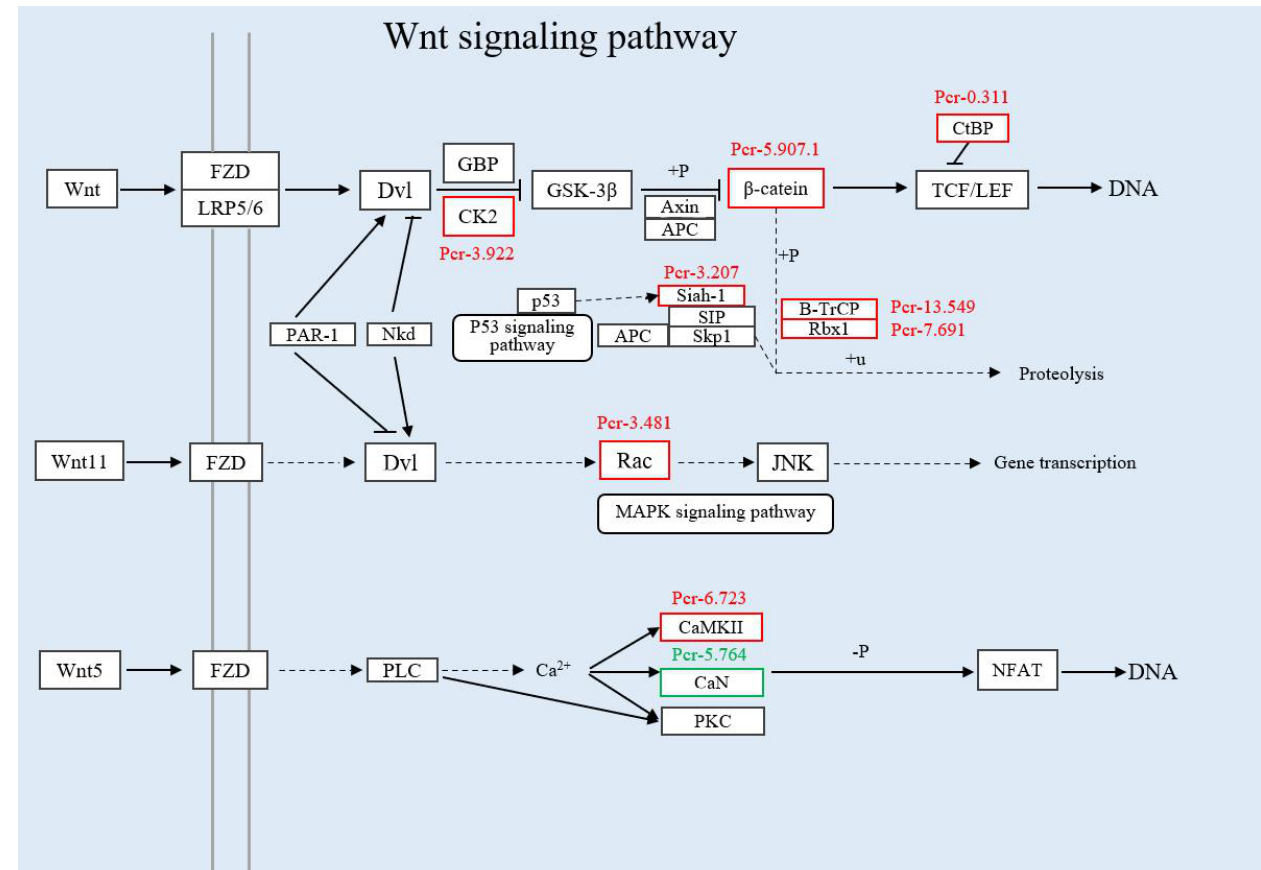
Figure 6. DEPs involved in the Wnt signaling pathway. The two vertical gray lines on the left represent the cell membrane, the solid line is the activation effect, and the dotted line is the indirect effect.